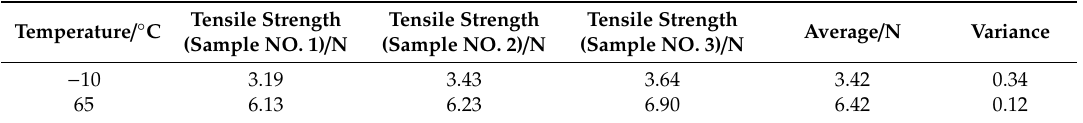
Table 8. Tensile properties of the blade top at the highest and lowest temperatures. Tensile Strength Temperature / ◦ C (Sample NO. 1) /